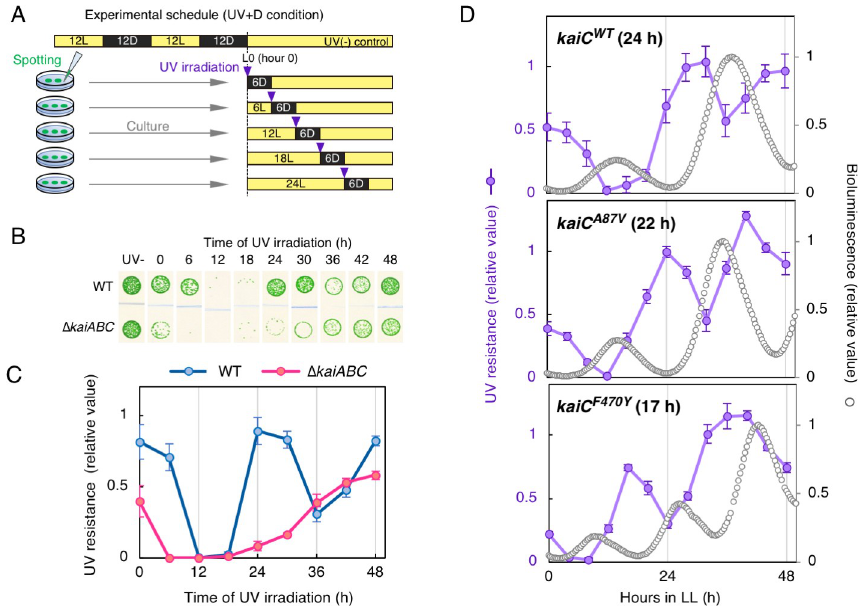
Fig 2. Synechococcus shows circadian variation of resistance to UV-C immediately followed by exposure to darkness. (A) A schematic representation of the experimental schedule (UV+D condition). Each symbol is the same as in Fig 1A. Cells were acclimated to 6 h of darkness after UV-C irradiation. (B) Growth of UV-C-irradiated cells. Each image represents a spot assay to assess growth following UV irradiation at each time point (upper label) under the UV +D condition. Representative data of three independent experiments are shown. (C) Densitometric analysis of the growth test in Fig 2B. The timing of UV irradiation is shown on the horizontal axis, and the relative UV resistance is shown on the vertical axis, as in Fig 1C ( n = 3). Error bars represent standard deviation. (D) Time profiles of UV-C resistance in periodic mutants. Each panel represents the results in control strain (Top), kaiC A87V mutant (middle), kaiC F470 mutant (bottom), respectively. Free-running period of each strain is noted in upper left of each panel. Densitometric data of UV resistance are represented with violet lines and filled circles ( n = 3). The timing of UV irradiation is shown on the horizontal axis, and the relative UV resistance is shown on the vertical axis on the left. Bioluminescence rhythms of each strain are also shown with open circles. Each strain harbored the P kaiBC :: luxAB reporter cassette, and the bioluminescence rhythms were measured under continuous light (LL) condition without UV. The levels of bioluminescence are shown on the vertical axis on the